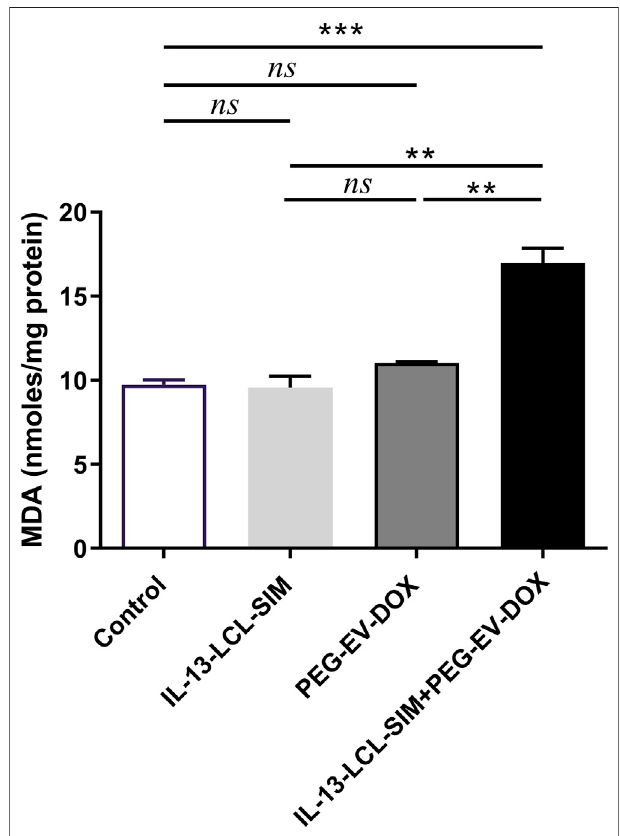
FIGURE 6 | Evaluation of the effects of nano-formulations on oxidative stress biomarker MDA in B16.F10 melanoma. MDA concentration was expressed as nano-moles MDA/mg protein. Measurements were performed in tumor lysates from mice treated with IL-13-LCL-SIM and PEG-EV- DOX as monotherapies as well as combined sequential therapy. Control, untreated group; IL-13-LCL-SIM, group treated with 5 mg/kg IL-13-LCL-SIM on days 7 and 10 after tumor cell inoculation; PEG-EV-DOX, group treated with 2 mg/kg PEG-EV-DOX on days 8 and 11 after tumor cell inoculation; IL- 13-LCL-SIM + PEG-EV-DOX, the group received the nano-formulations sequentially, IL-13-LCL-SIM 5 mg/kg on days 7 and 10, respectively, and PEG-EV-DOX 2 mg/kg on days 8 and 11 after tumor cell inoculation; ns , p > 0.05; **, p < 0.01; and ***, p < 0.001.